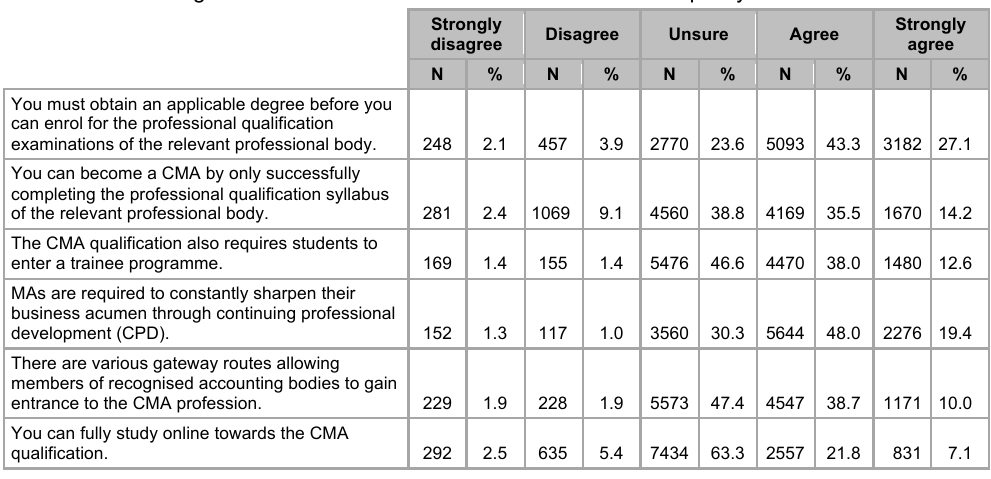
Rating of statements on: the route to follow in order to qualify as a